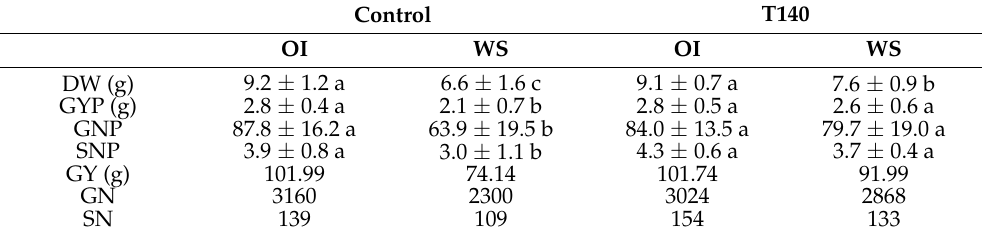
Data are calculated from 12 replicates per treatment and irrigation condition ( n = 12). Values in the same row with different letters are significantly different according to one-way analysis of variance (ANOVA) followed by Tukey’s test ( p < 0.05).